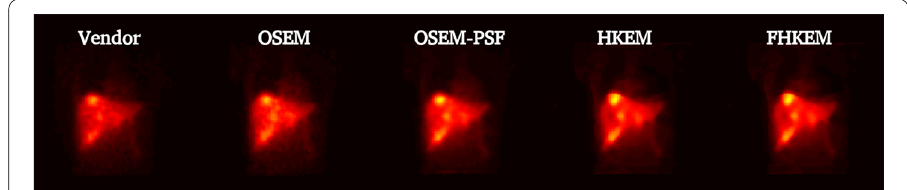
Fig. 10 Images at the highest CNR from Patient 4. Comparison between vendor, OSEM, OSEM‑PSF, HKEM and FHKEM frozen at the 72nd sub‑iteration. All images use the same scale